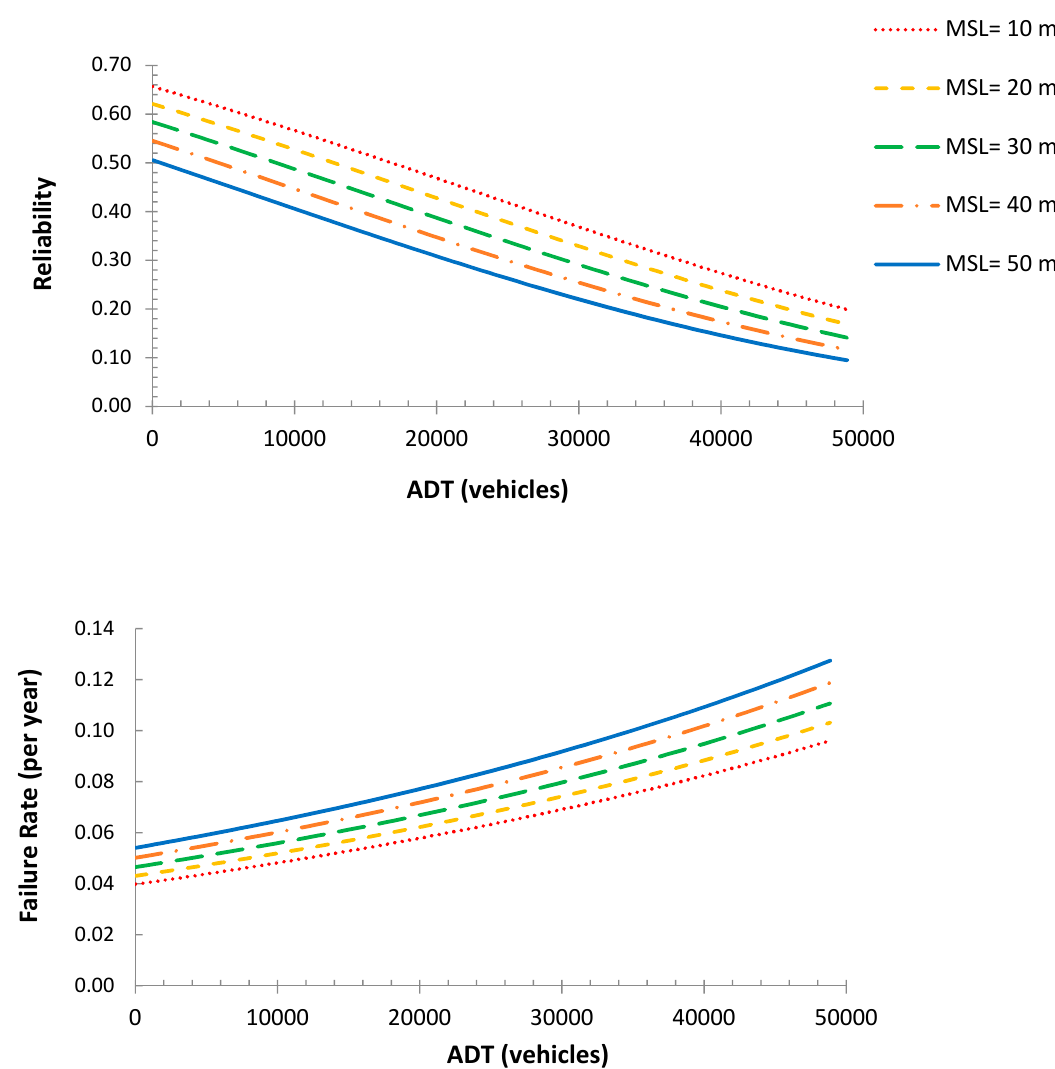
Figure 4. Superstructure reliability and hazard rate versus ADT at different maximum span length at the age of 50 years (All superstructure types).